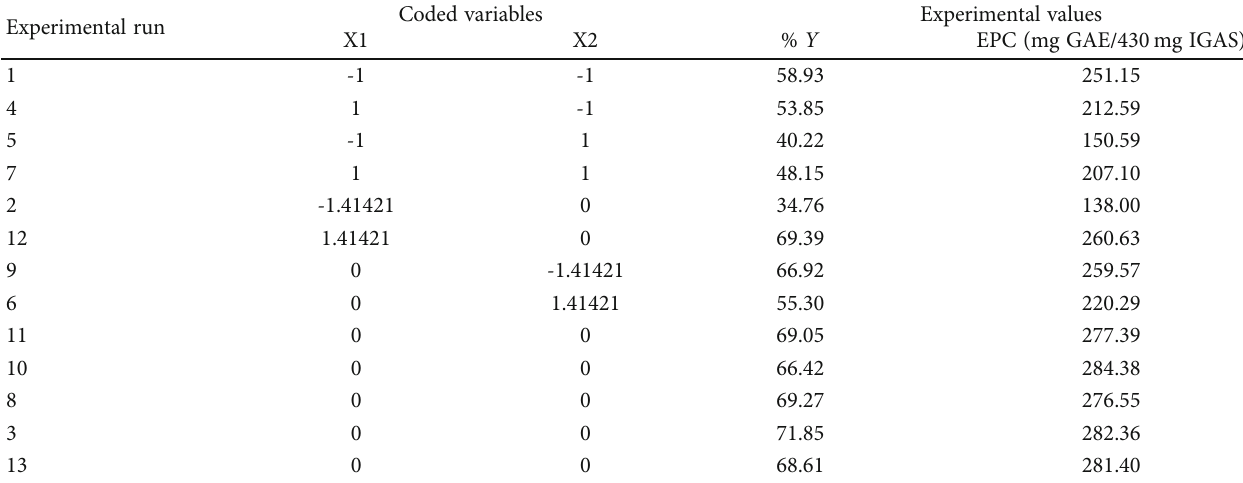
Table 4: Experimental values of the